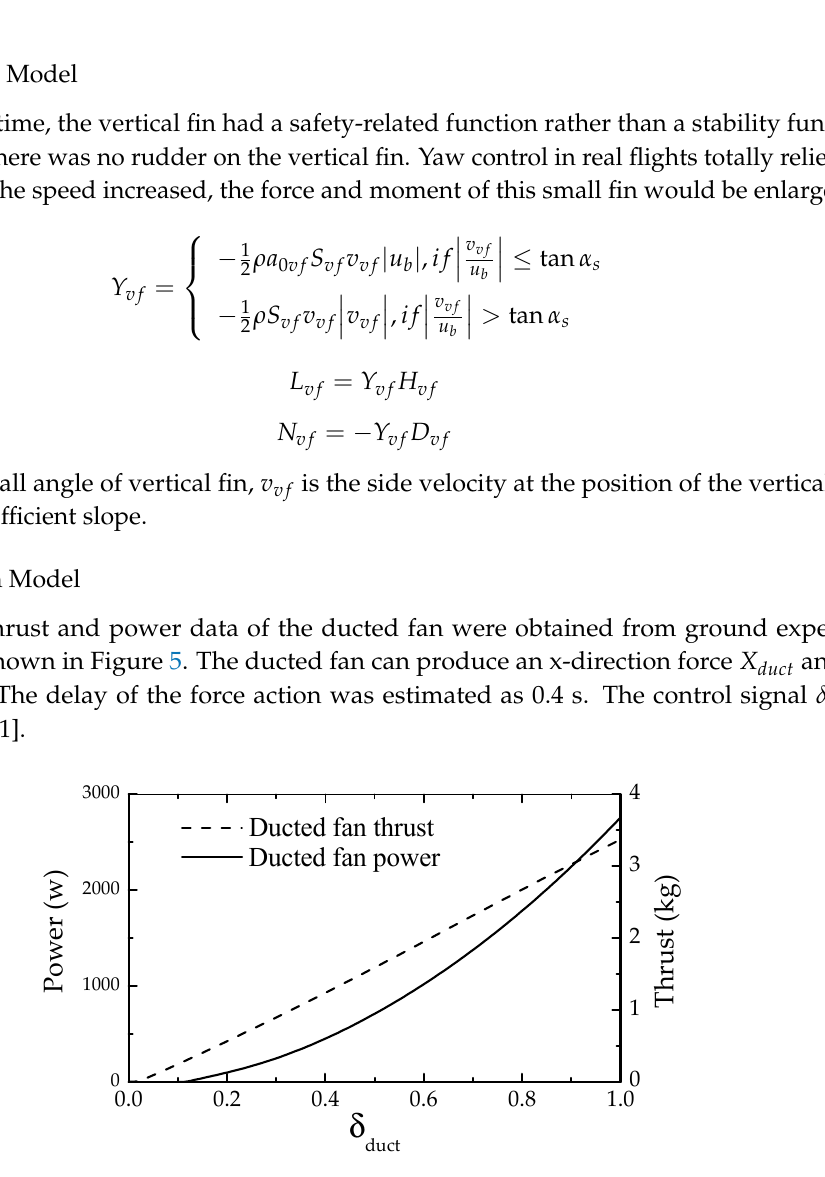
Figure 5. Ducted fan thrust and power curves.